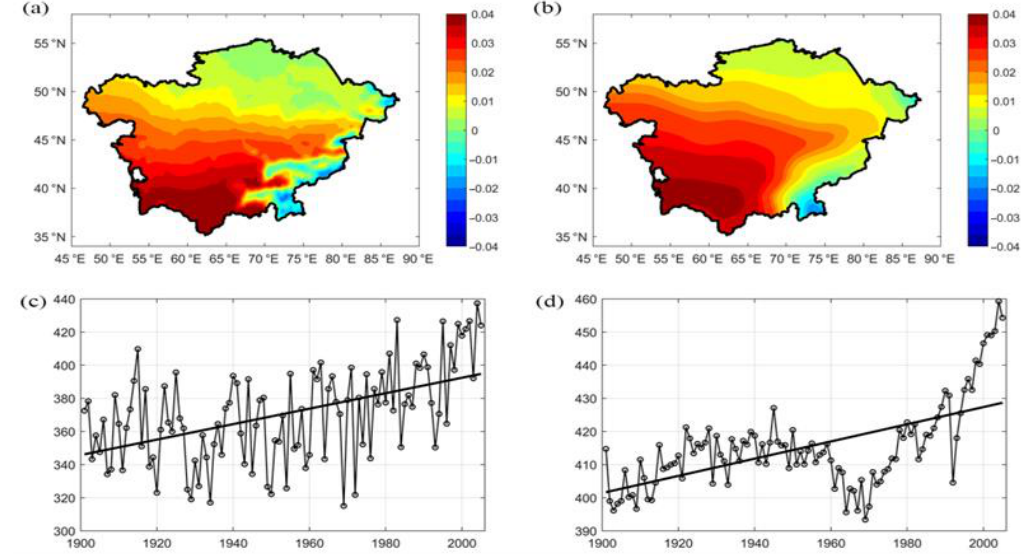
Figure 6. Spatial distributions of the first mode of the annual mean SAT of ( a ) the observed data and ( b ) the MME, with first time coefficients for ( c ) the observed data and ( d ) the MME.